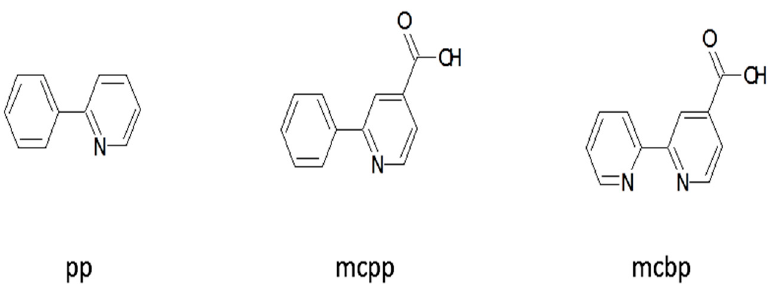
Figure 36. Pp, mcpp, mcbp.